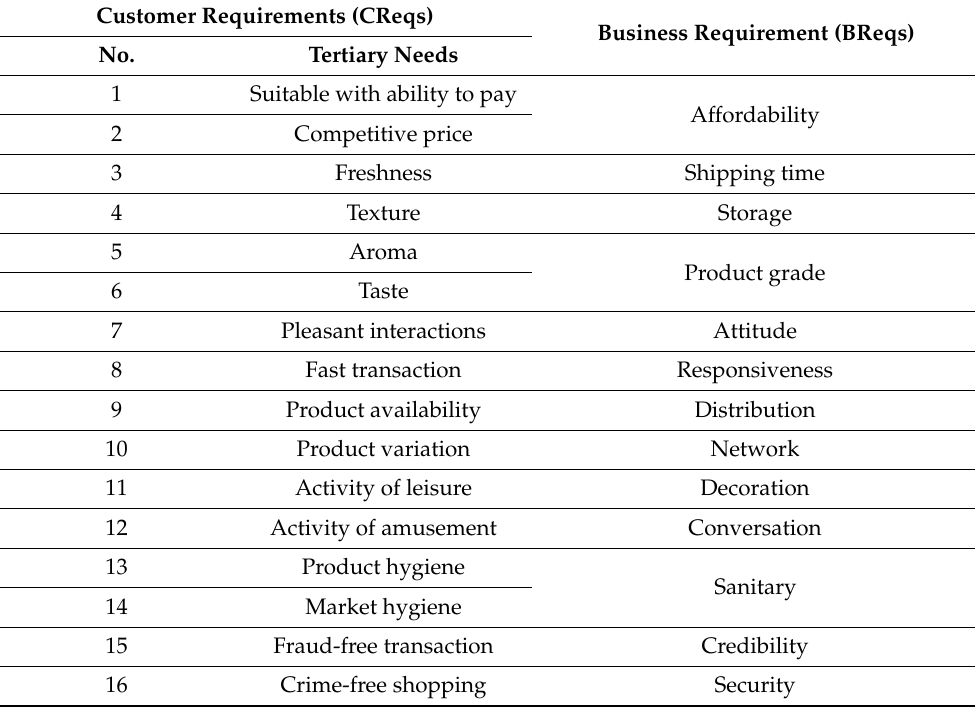
Table 3. Customer requirement (CReqs) to business requirements (BReqs) translation matrix. Customer Requirements